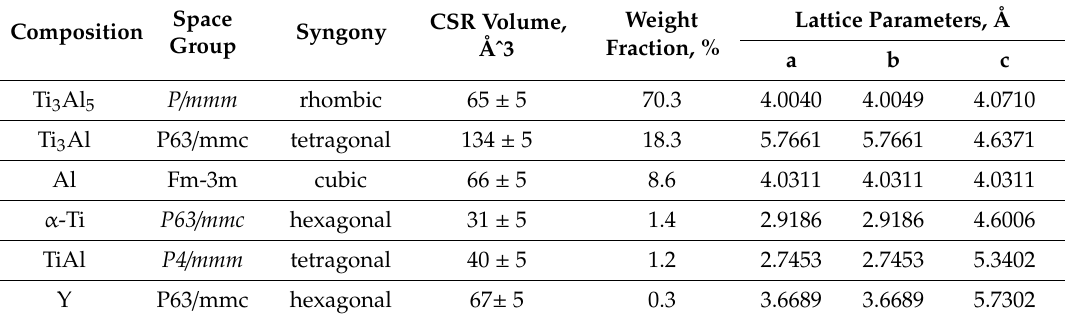
Table 8. Crystallographic data of phases in the TAY system.